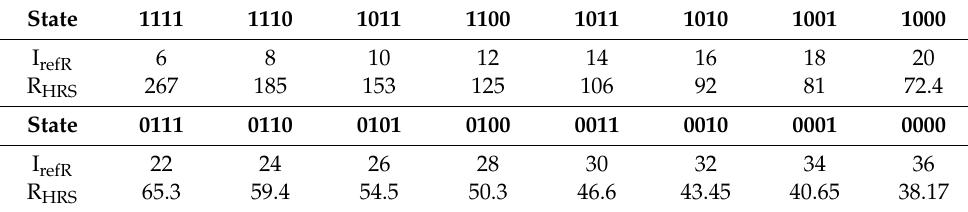
Table 2. Allocation of the 16 resistance levels ranging from 38 k Ω to 267 k Ω .